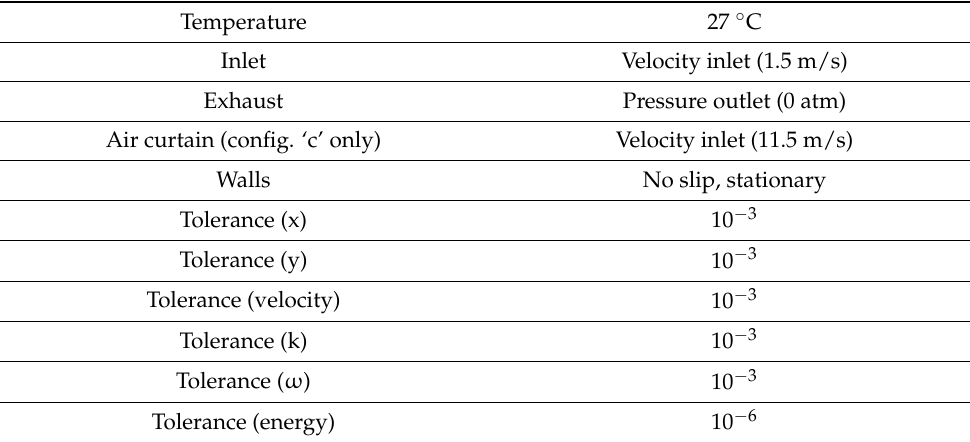
Table 1. Initial conditions used in ANSYS